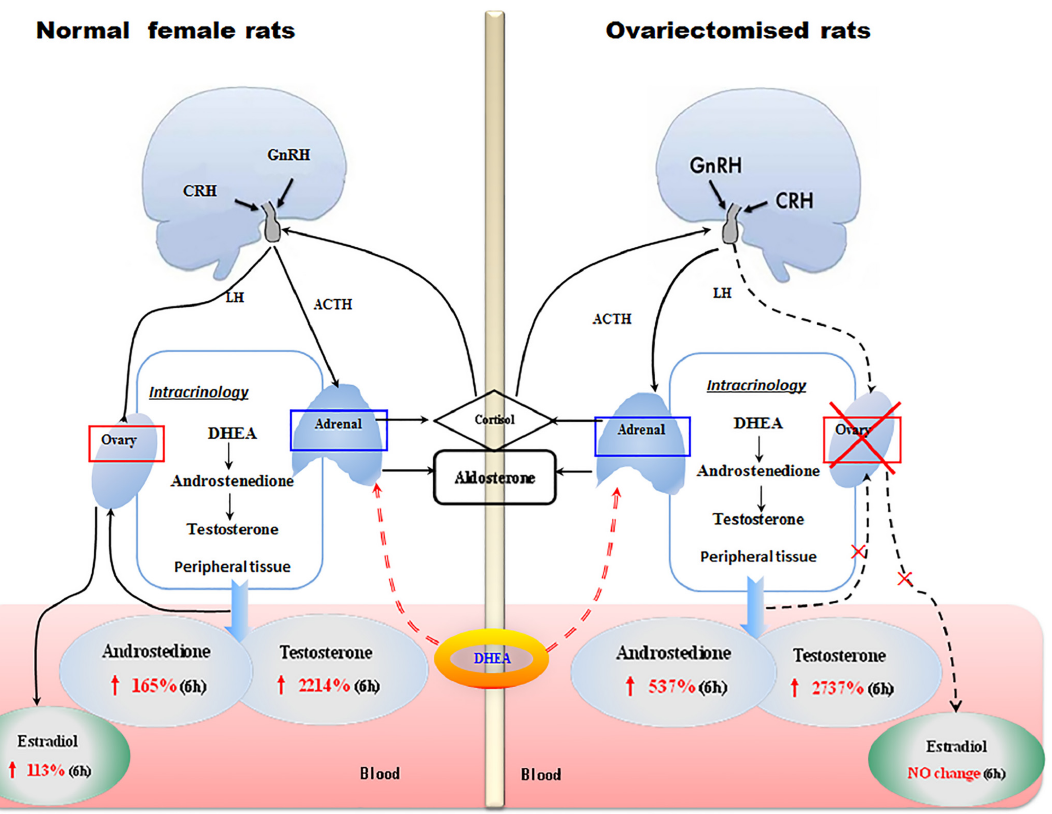
Fig 6. Conversion of exogenous DHEA in female rats. Left scheme represents the role of ovarian and adrenal on the exogenous DHEA conversion to activated steroid hormones in female rats. Serum androstenedione, testosterone and estradiol content significantly increased at 6h after DHEA administration. In adrenal glands, 3 β -HSD and 17 β -HSD mRNA levels were increased after DHEA administration, no difference change was observed on aromatase mRNA level. However, 3 β -HSD mRNA level were decreased and aromatase mRNA level increased in ovary after DHEA administration, there was no difference on 17 β -HSD mRNA expression levels. Right scheme represents the mainly peripheral target tissue of DHEA convert to activated steroid hormones in ovariectomised (OVX) rats, namely adrenal glands. Serum androstenedione and testosterone contents significantly increased in ovariectomised rats after DHEA administration, no changes were observed on estradiol and estrone content. The 3 β -HSD and 17 β -HSD mRNA levels were increased in adrenal after DHEA administration, while aromatase mRNA level was decreased.